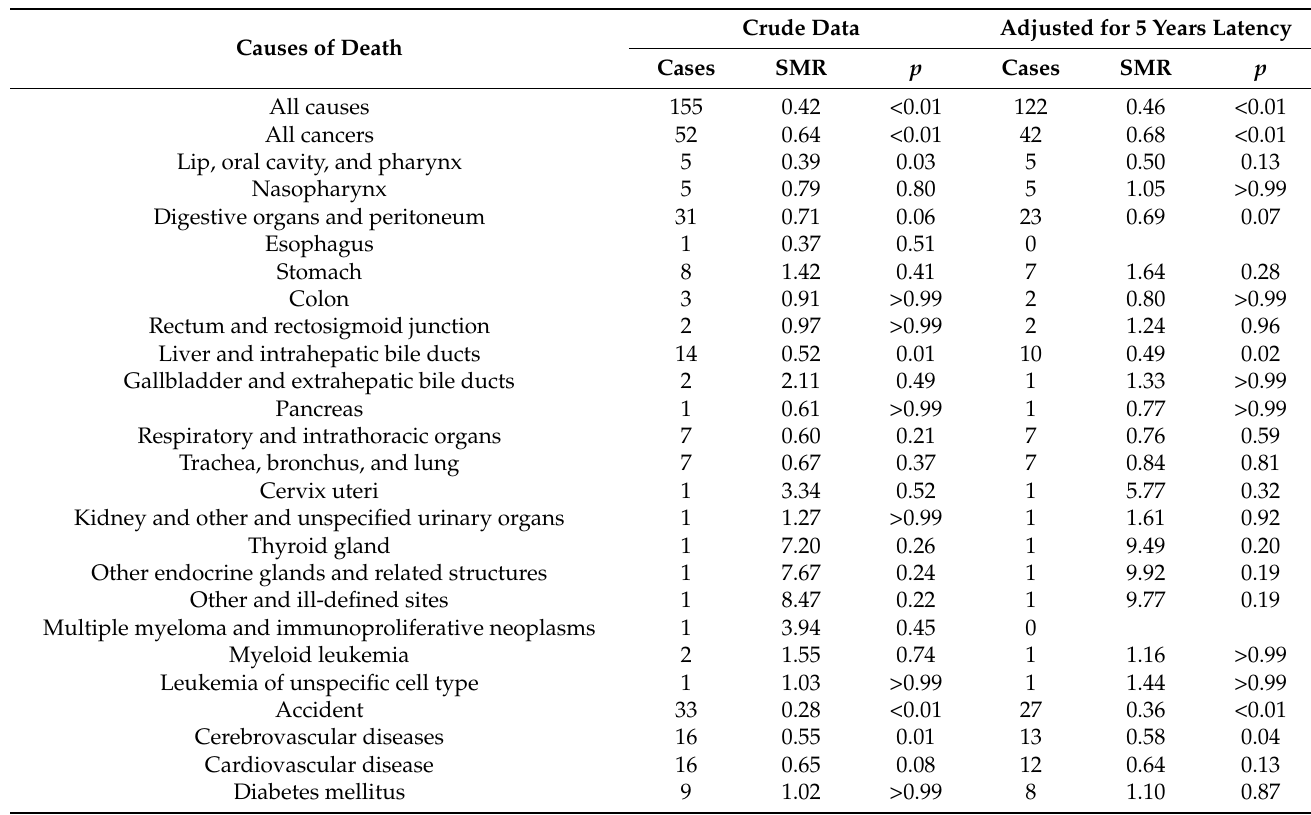
Table 1. Standardized mortality ratios (SMRs) of various causes of death from 1985 to